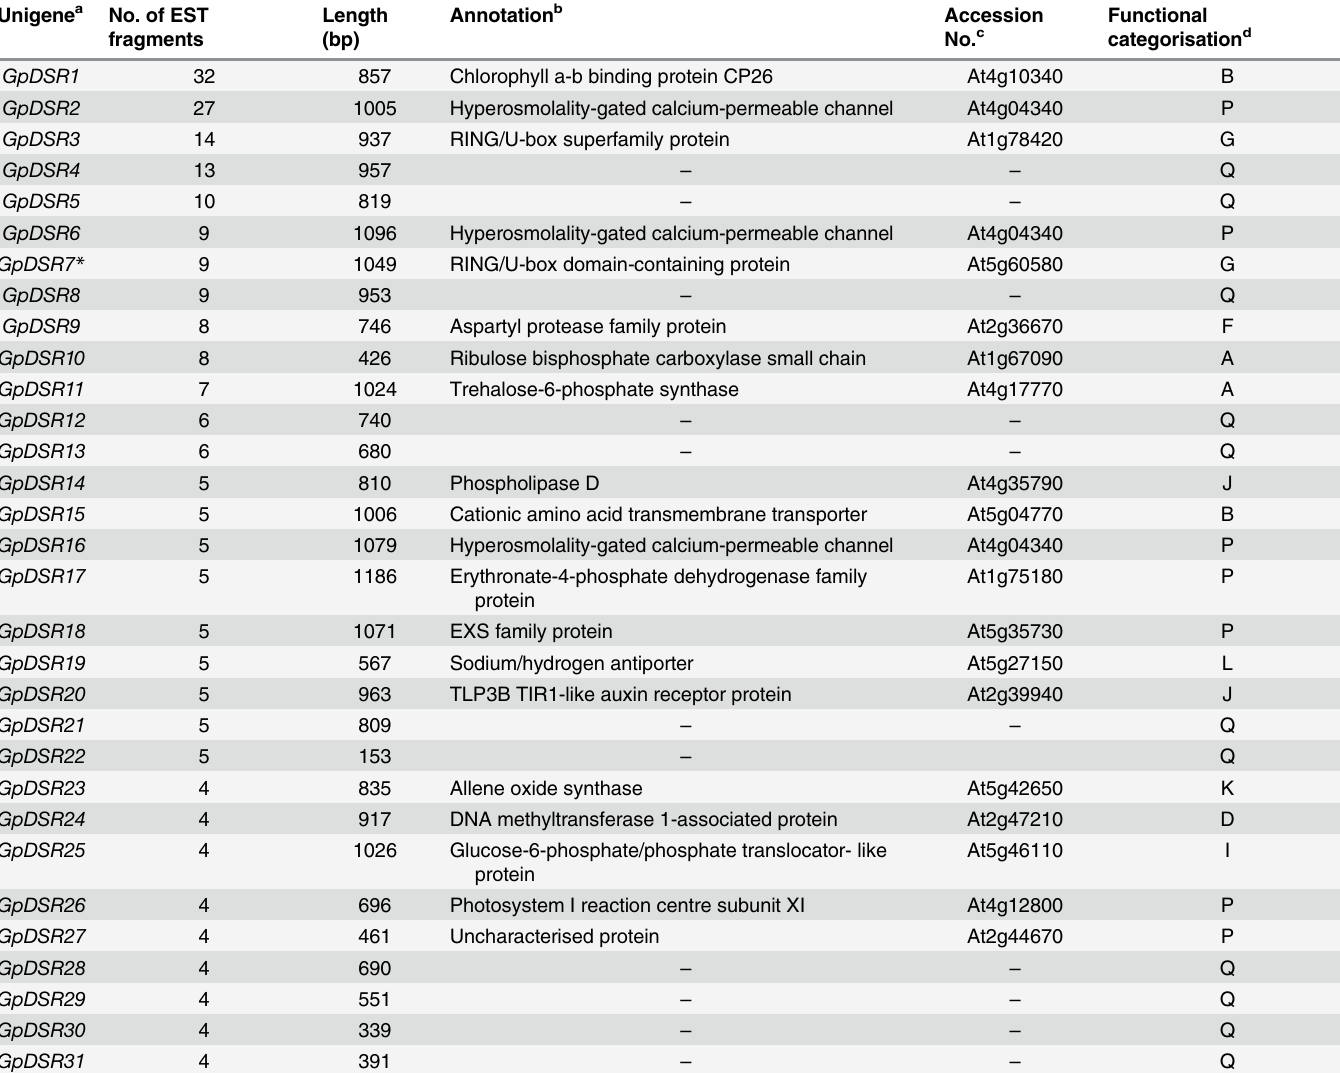
Table 1. Unigenes assembled with more than four ESTs annotated by sequence similarities. Unigene a